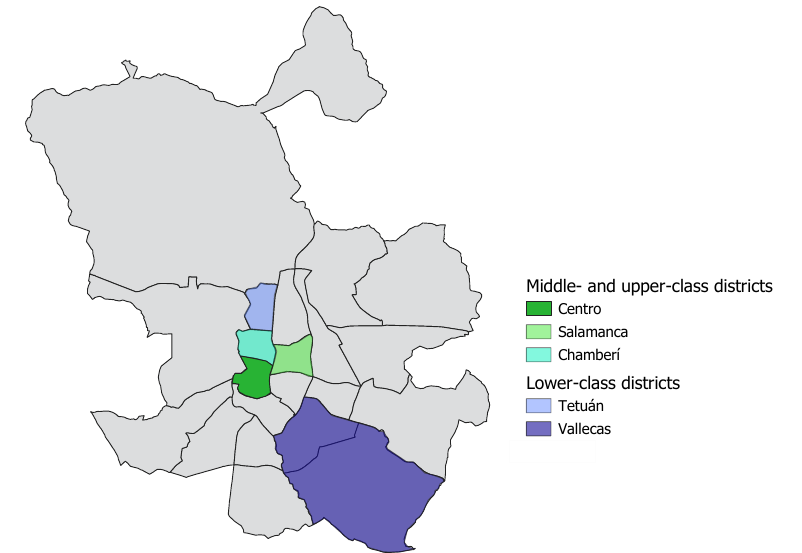
Figure 1. Map of Madrid and the analysed districts (modified from [34]).